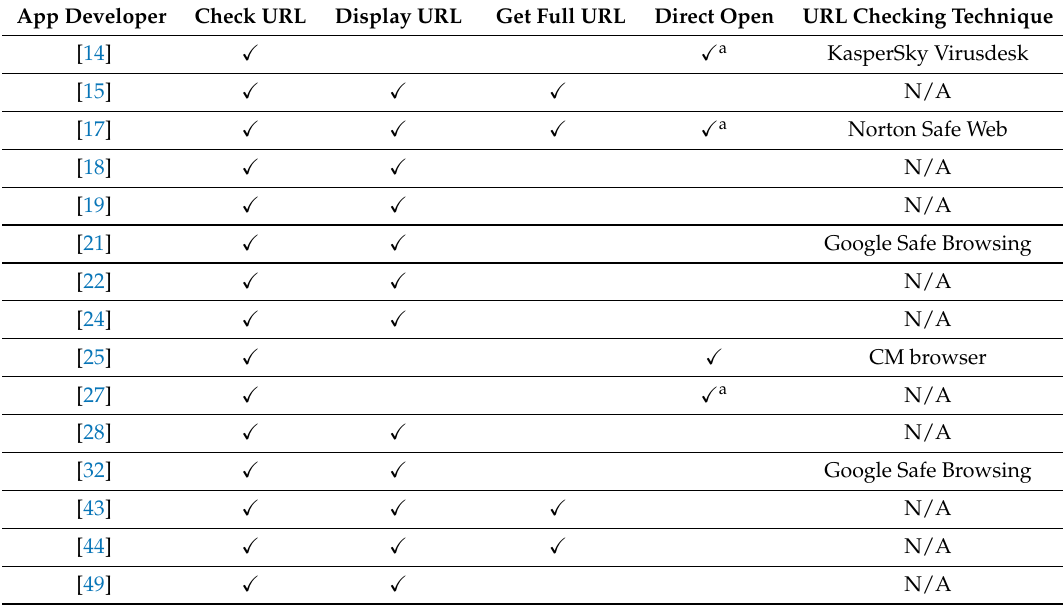
Table 2. Barcode Scanners that check URLs contained Inside QR codes. App